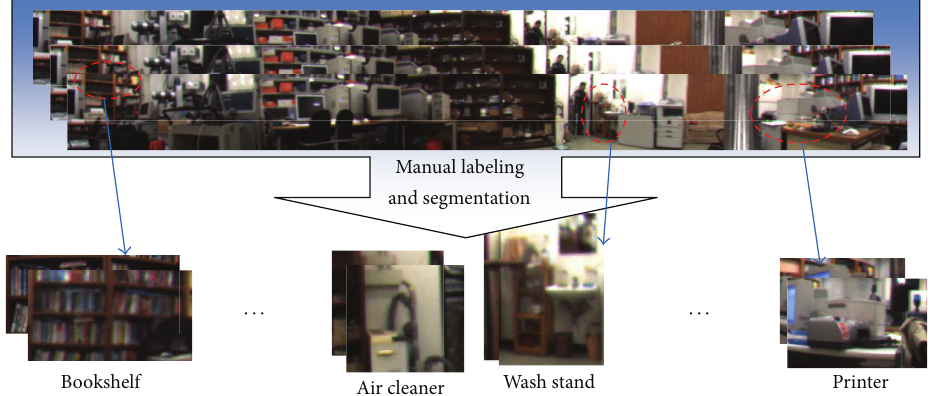
Figure 13: Preparation of object images for learning.